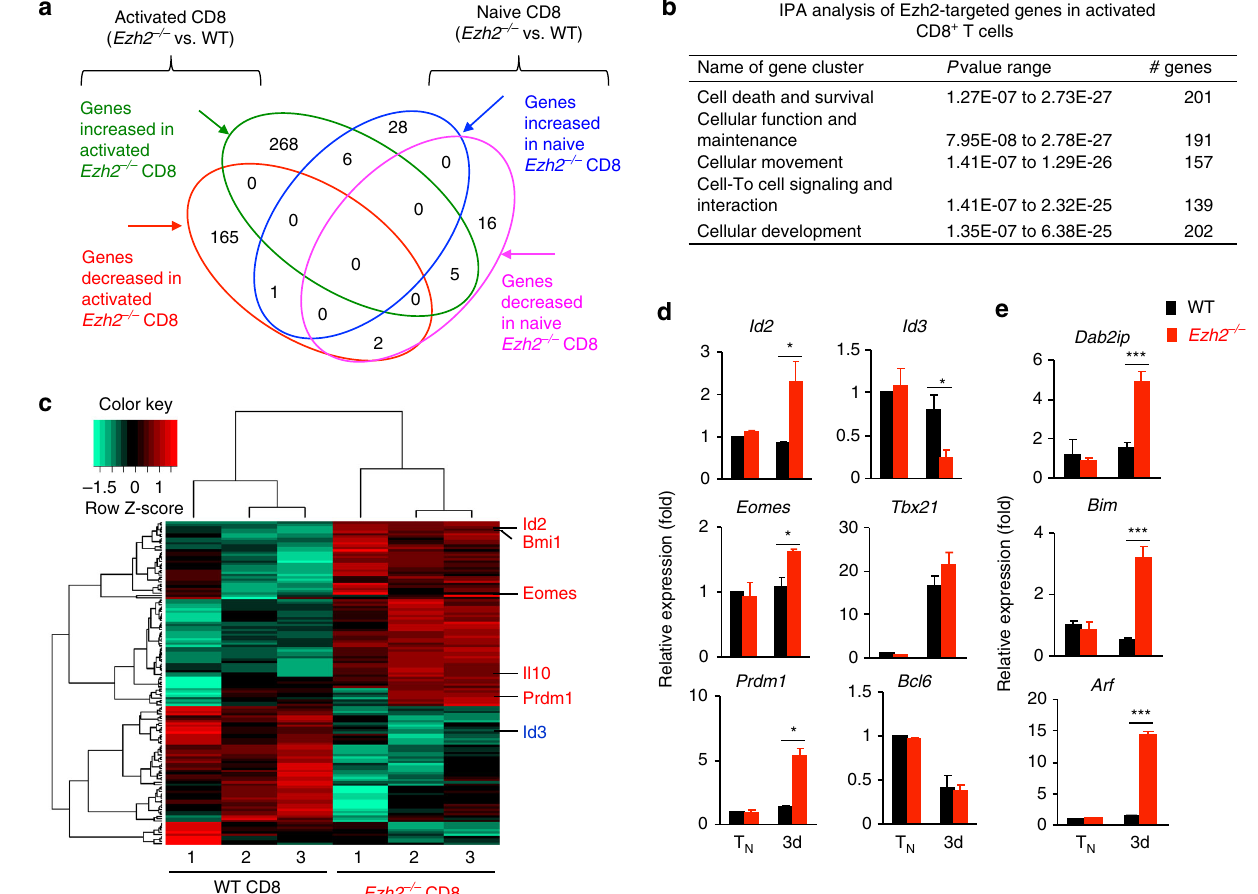
Fig.3 Ezh2 orchestrates the expression of genes critical for effector differentiation and memory formation. a – c WT and Ezh2 − / − Pmel-1 cells were cultured in the presence of anti-CD3/CD28 Abs and IL-2 for 3 days. Cells were collected to extract RNA for sequencing. Using one-way ANOVA analysis, we selected transcripts with p < 0.01 and q < 0.01 for comparing paired groups and at least a 1.5-fold difference from the means for the paired groups. a Venn diagram shows the number of differentially expressed genes. b Table shows the signaling pathways most regulated by Ezh2 in activated Pmel-1 cells, which was identi fi ed by INGENUITY pathway analysis. c Heat map shows the cluster of genes associated with Cell Function and Maintenance in activated WT and Ezh2 − / − Pmel-1 cells. d , e Gene expression was assessed by real-time RT-PCR. * p < 0.05, and *** p < 0.001 (two-tailed unpaired t test). The data are representative of four independent experiments ( d , e ; mean ±